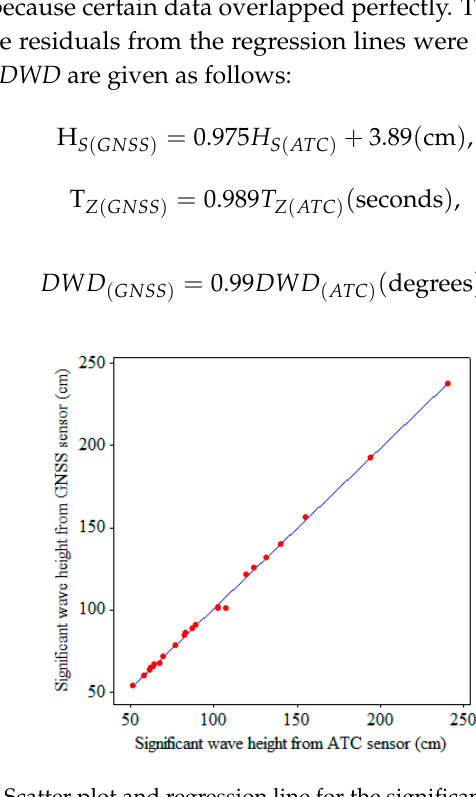
Figure 10. Scatter plot and regression line for the significant wave heights.